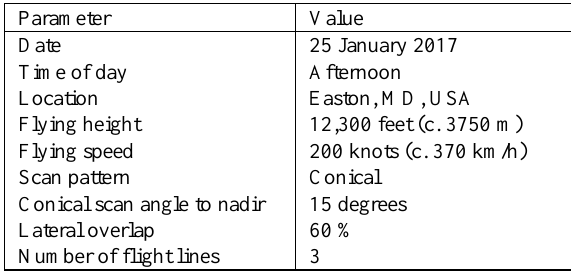
Table 2. Analysis of Leica SPL100 multiple returns for Easton dataset (1 % sample).